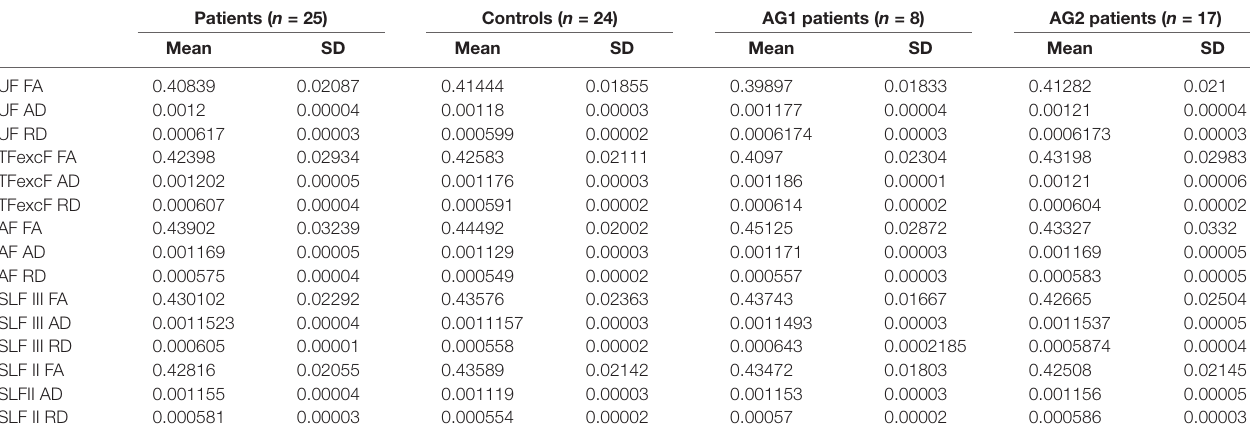
TABLE 5 | Mean and standard deviations for FA, AD, and RD values of the right hemisphere UF, TFexcF, AF, SLF III, and SLF II white matter tracts for all participants.